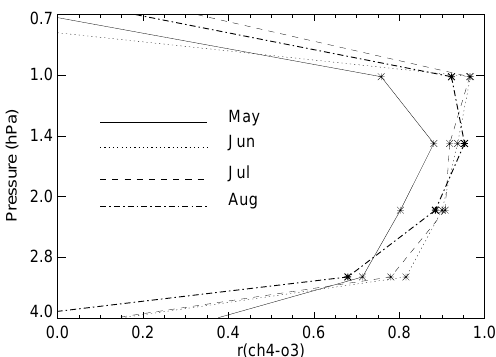
Figure 10. Altitude profiles of linear correlation coefficients for SOFIE CH 4 and MLS O 3 (sampled at the SOFIE occultation lat- itudes). The four curves are taken from zonal mean averages for May (solid), June (long dashes), July (dotted) and August (dot-